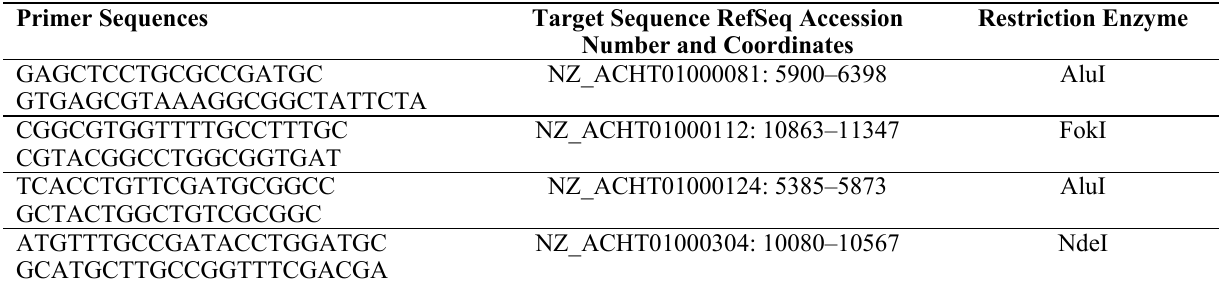
Table 5. Polymerase chain reaction (PCR) primers used for distinguishing the two sub-lineages by restriction fragment length